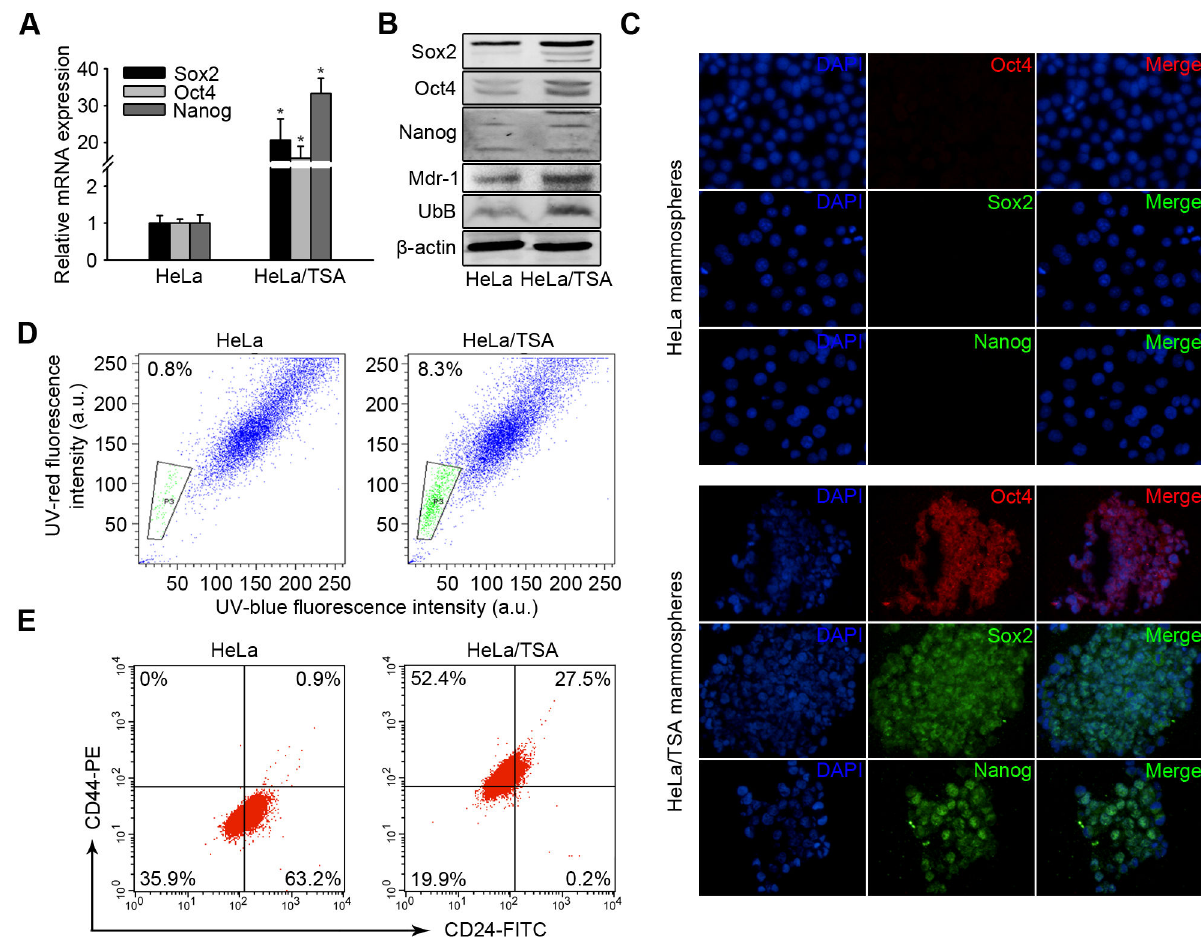
Figure 3. HeLa/TSA cells were enriched of cancer stem-like cells. A , HeLa/TSA mammosphere cells were analyzed for the Sox2, Oct4 and Nanog mRNA levels. The columns represent the average of three separate experiments; error bars, SD. B , The quantitative analysis of Sox2, Oct4, Nanog, Mdr-1 and UbB protein levels by western blotting. C , HeLa/TSA mammosphere cells were analyzed by immunofluorescence for Sox2, Oct4 and Nanog. The representative photographs were taken using a fluorescence microscope (original magnification, ×200). The nuclei were presented as detected using DAPI (4′, 6-Diamidino-2- phenylindole) staining. D , The analysis of the side-population cell fraction in HeLa and HeLa/TSA cell cultures. Left panel: HeLa; right panel: HeLa/TSA. E, The analysis of CD44 and CD24 expression of HeLa and HeLa/TSA cells. Left panel: HeLa; right panel: